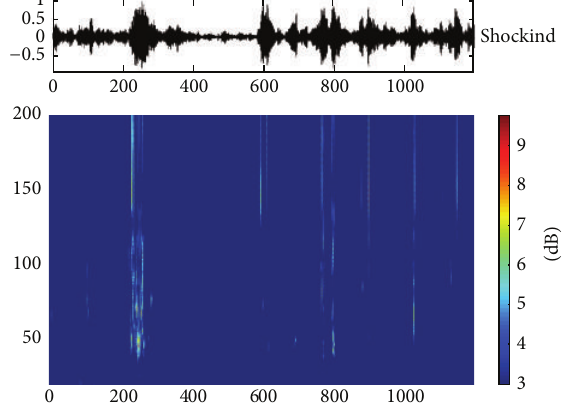
Figure 4: Significant shock